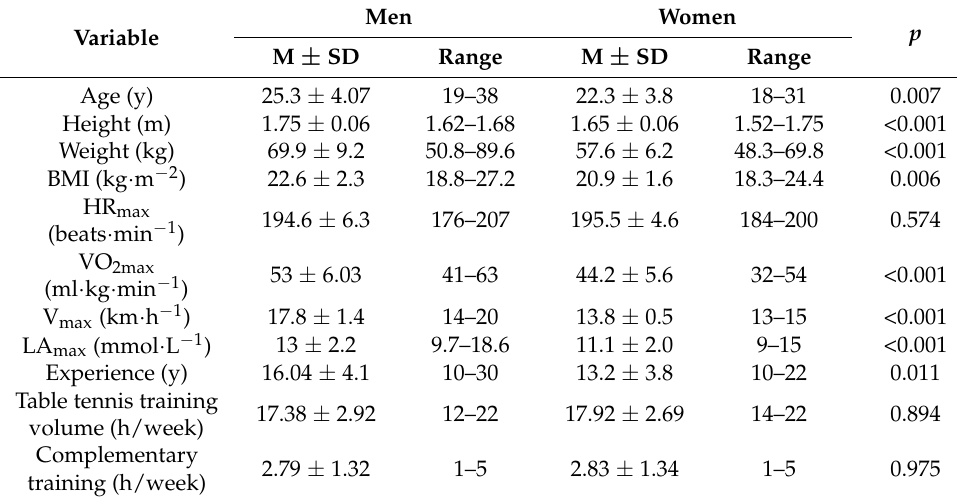
Table 1. Table tennis players’ characteristics.